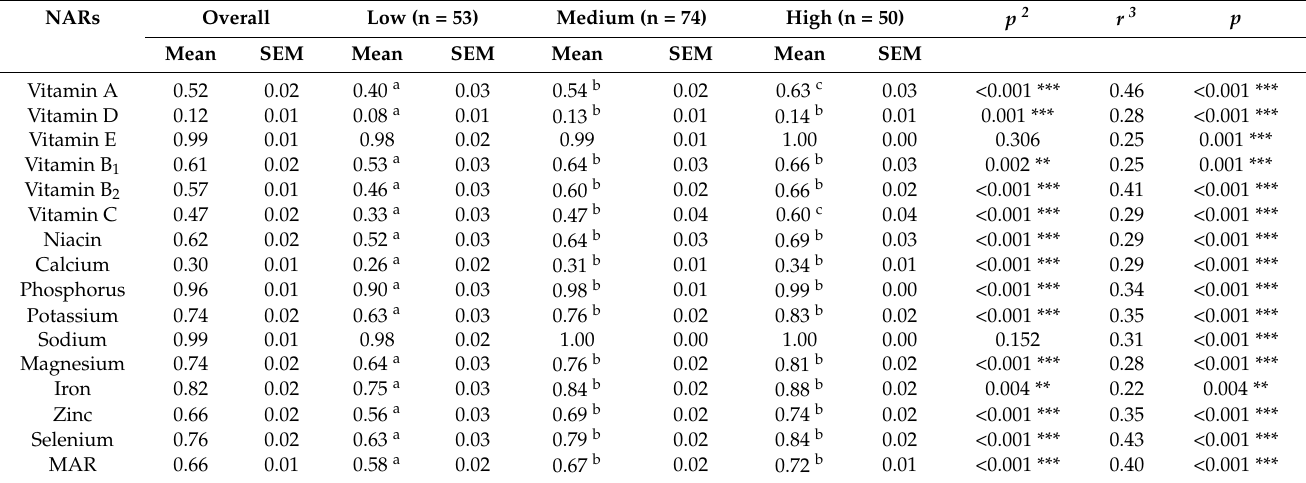
Table 2. NARs and MAR among participants in DDS low, medium, and high groups (n =